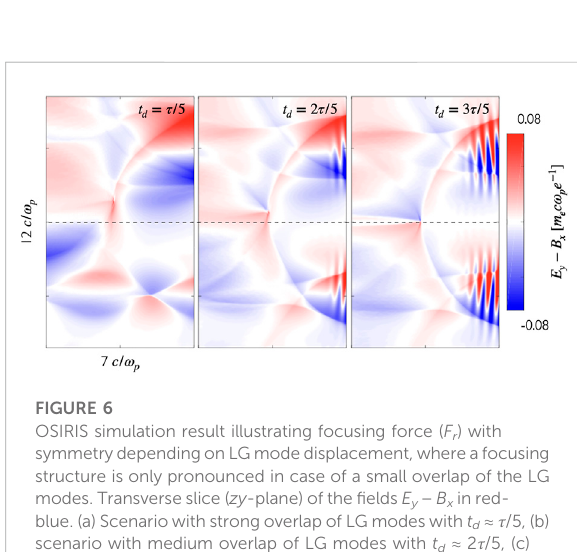
FIGURE 6 OSIRIS simulation result illustrating focusing force ( F r ) with symmetrydependingonLGmodedisplacement,whereafocusing structure is only pronounced in case of a small overlap of the LG modes. Transverse slice ( zy -plane) of the fi elds E y − B x in red- blue. (a) Scenariowith strong overlap of LG modes with t d ≈ τ /5,(b) scenario with medium overlap of LG modes with t d ≈ 2 τ /5, (c) scenario with small overlap of LG modes with t d ≈ 3 τ